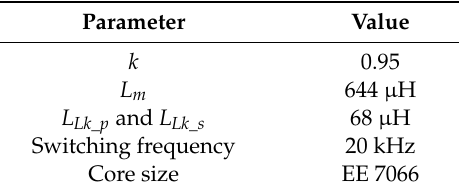
Table 5. Parameters for two-phase CI.